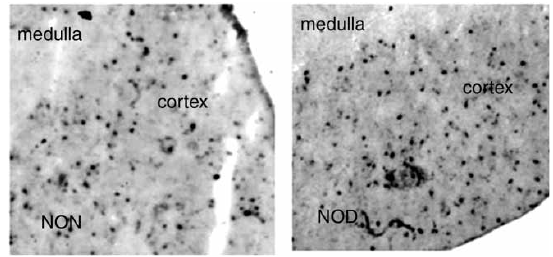
FIGURE 2 In situ hybridization of Prss16 to thymi from NOD and NON